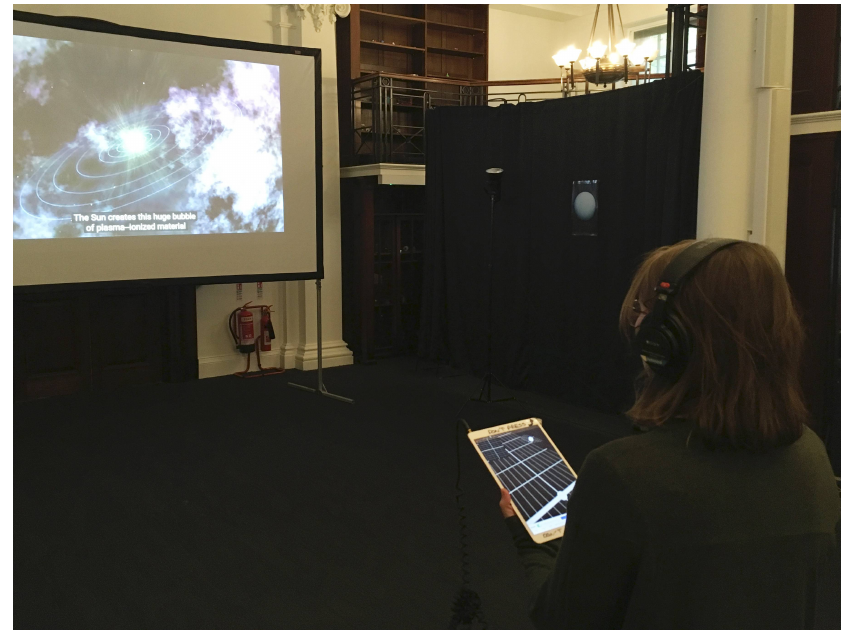
Figure 6. Participant using the Soundscape Mobile app for part 3 of the